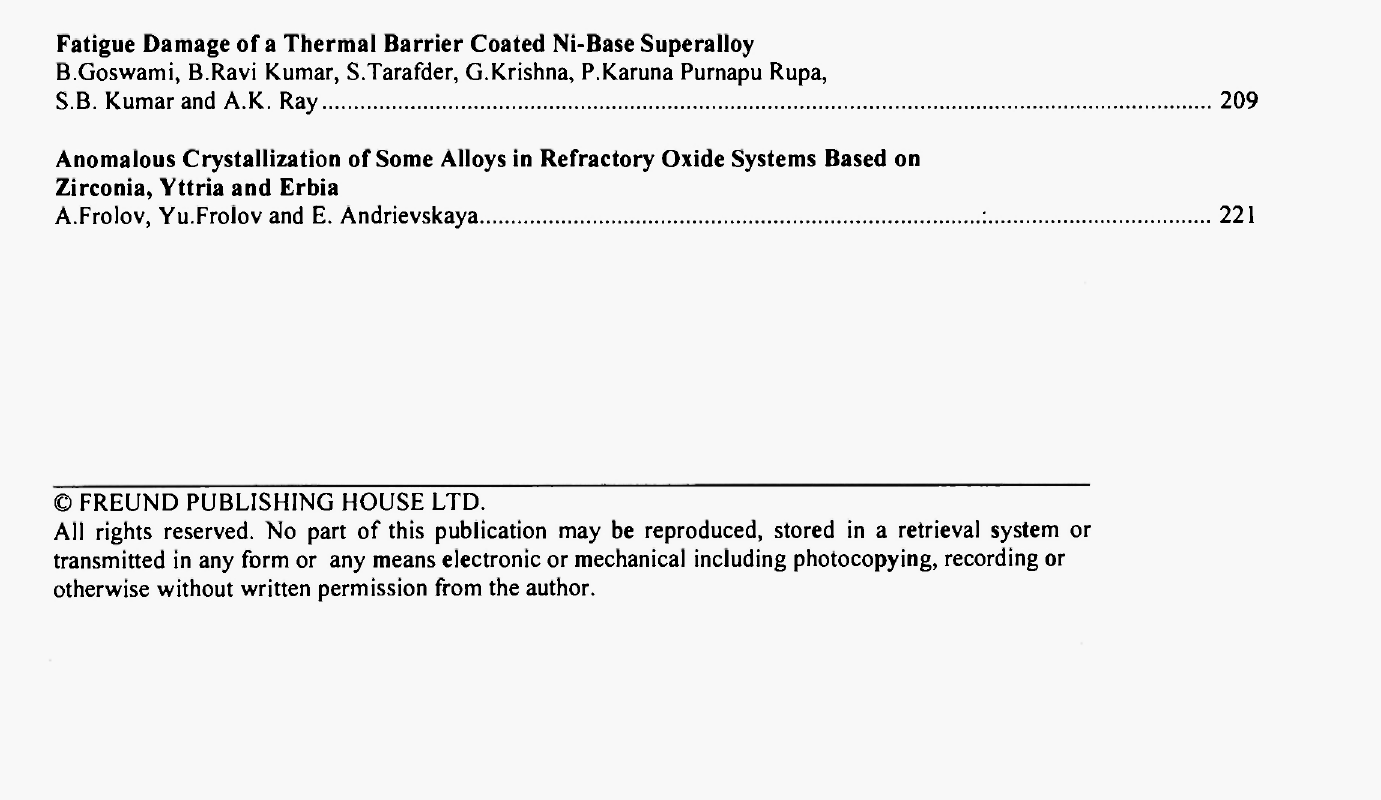
Characterization of Hot Corrosion of Fe-20Cr Coated with a Fused (Na,K) 2 S0 4 Film By Electrochemical Impedance